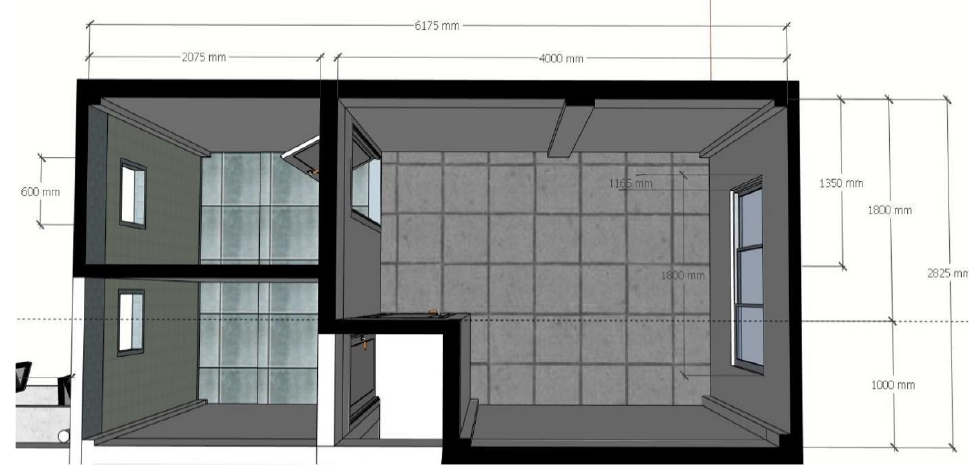
Figure 3. Plan view of the modelled case study room (master bedroom with attached bathroom).